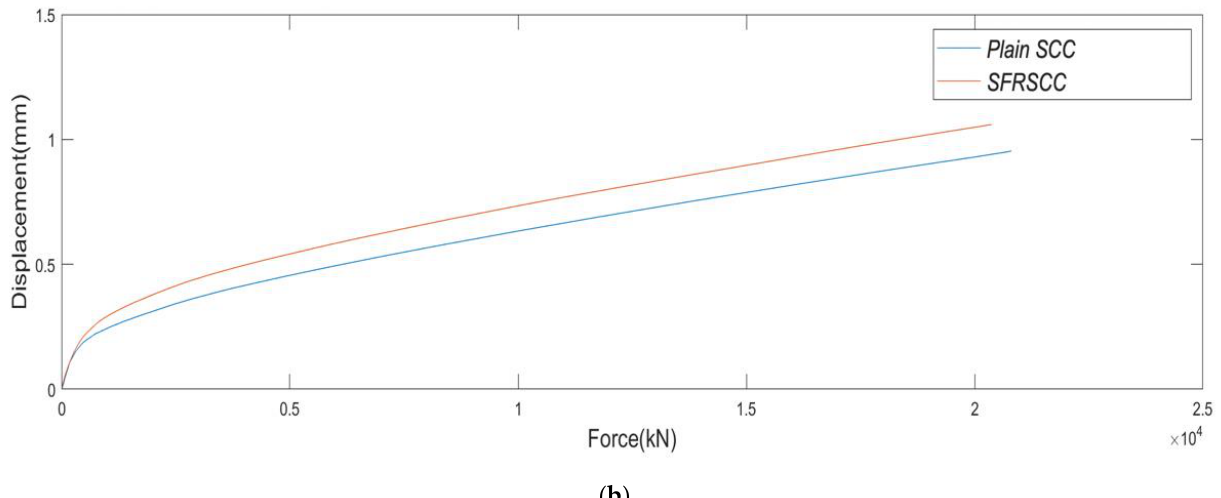
Figure 3. Three-point bending test results for plain SCC and SFRSCC specimens; ( a ) force vs. time curves, and ( b ) dis- placement vs. force curves.